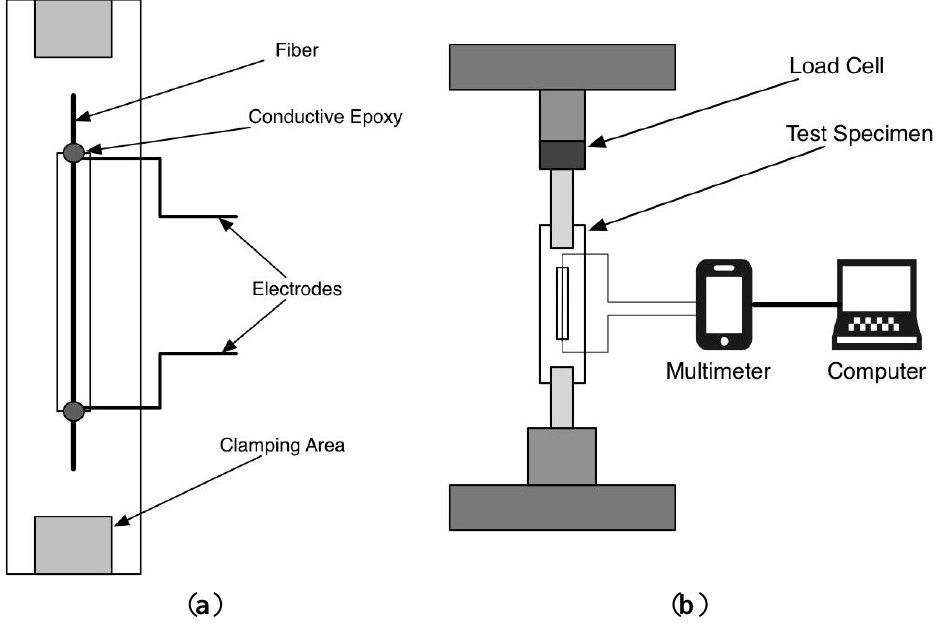
Figure 1. ( a ) Tensile specimen test frame with monofilament position and electrodes; ( b ) Tensile test setup, including testing machine and resistance signal monitoring.